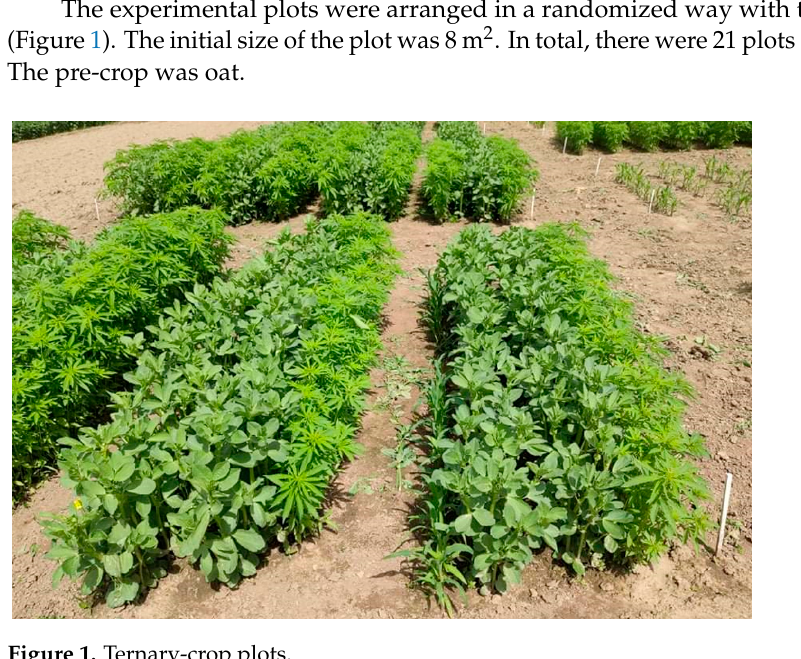
Figure 1. Ternary-crop plots.